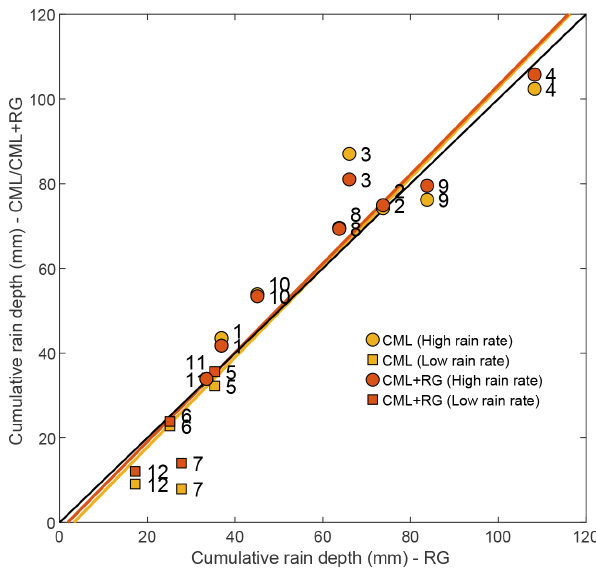
Figure 6. Rainfall depths, averaged over the catchment area and accumulated at the end of each of the 12 events. The numbers next to the markers refer to the event ID, while the two different markers represent high-rain-rate (circles) and low-rain-rate (squares) events. The black line represents the 1 : 1 line – a perfect match between rainfall depth estimates from RGs and from CMLs (yellow) or from the combination of RGs and CMLs (orange). Yellow and orange lines are the corresponding regression